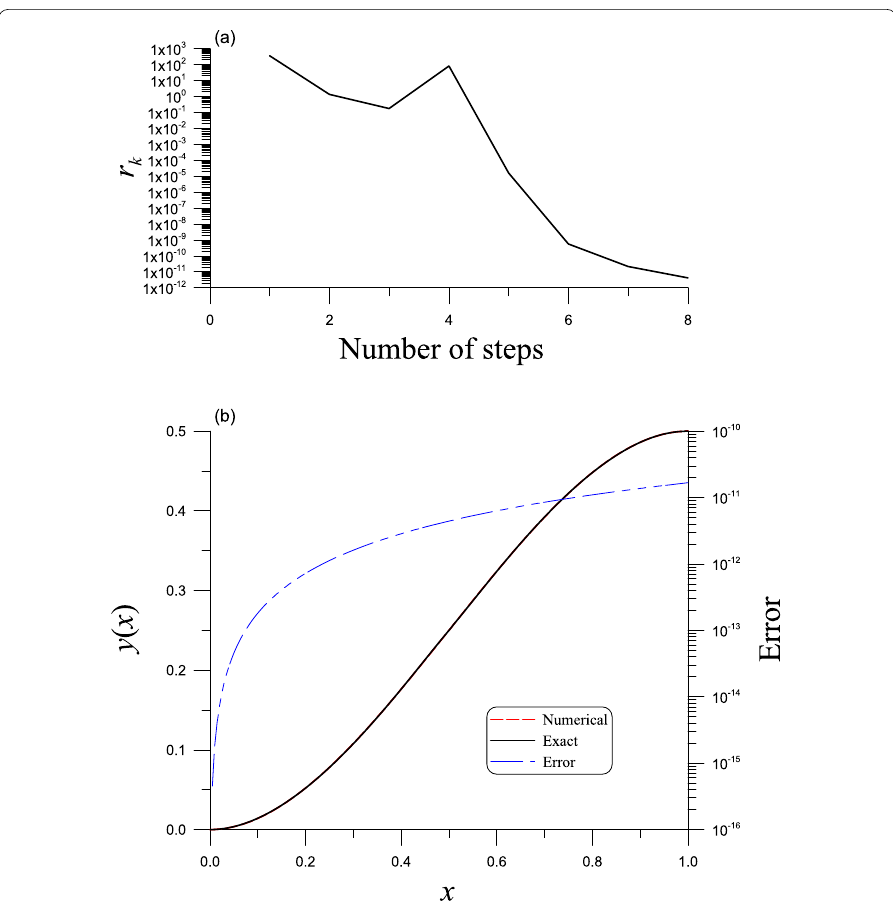
Figure 7 For Example 5 of a non-separated three-point BVP solved by the BSFM, ( a ) showing convergence behavior and ( b ) comparing numerical and exact solutions and showing numerical error